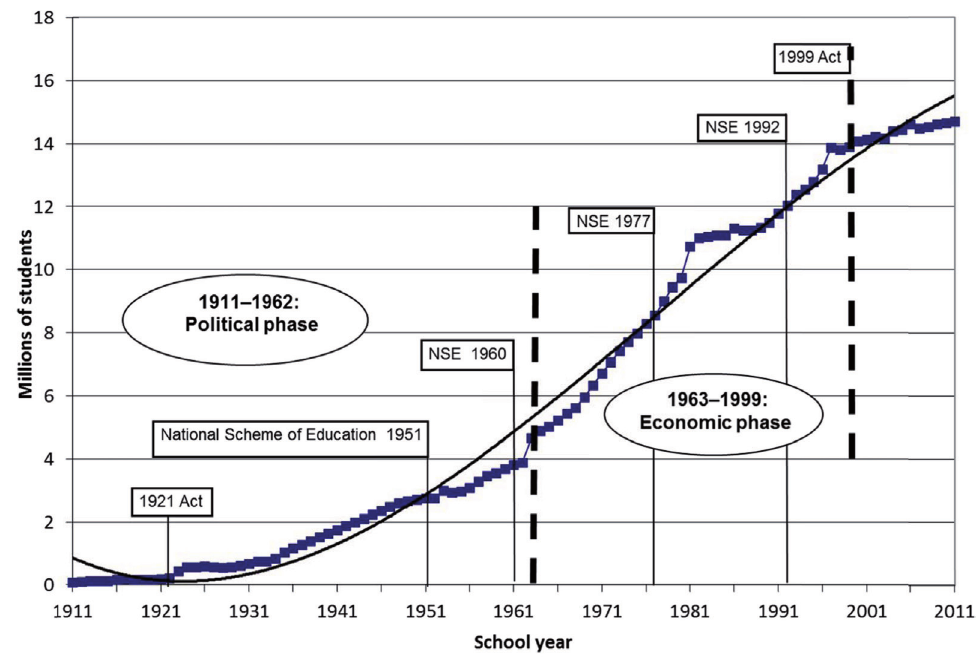
Figure 1: Total enrolment in education from 1911 to